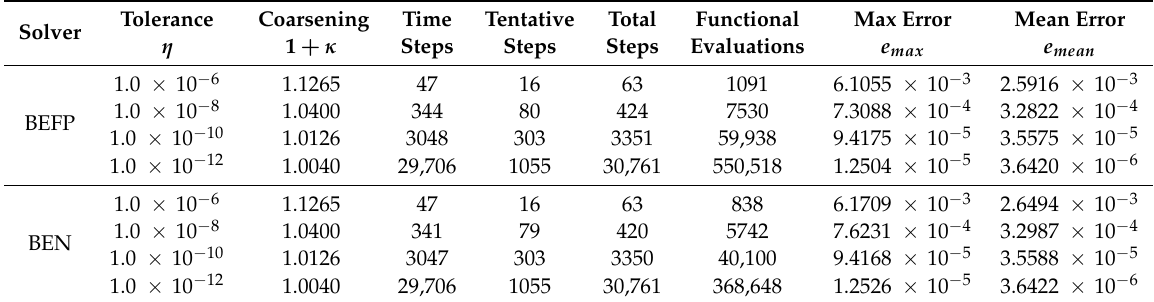
Table 1. Shifted Strang–Marchuk splitting method for Bernoulli’s equation.